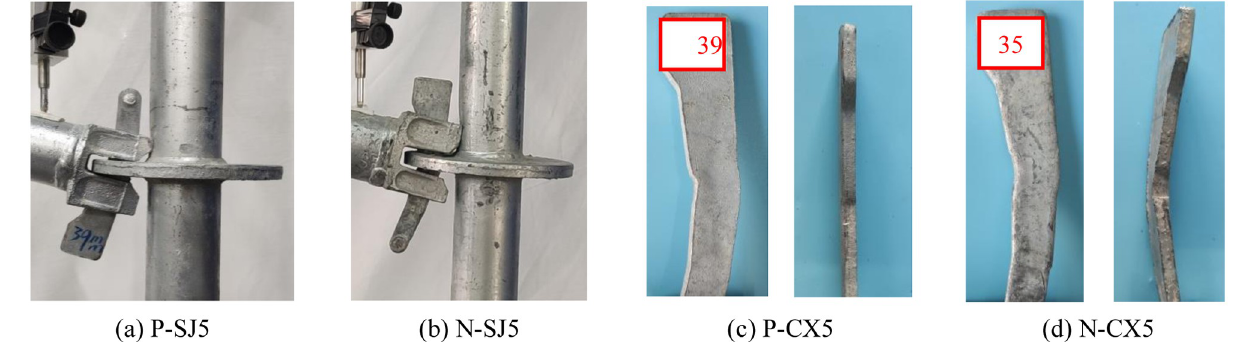
Fig 7. Wedge failure modes. (a) P-SJ5. (b) N-SJ5. (c) P-CX5. (d) N-CX5.